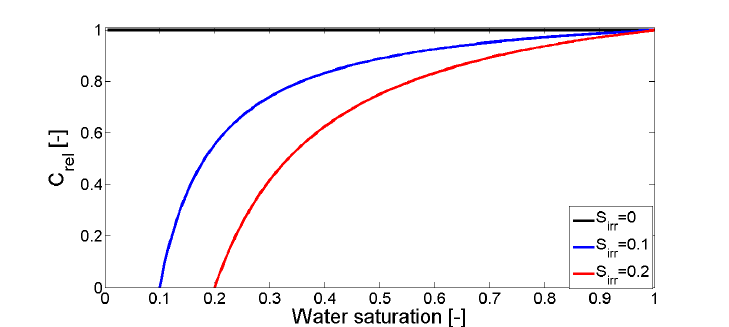
Figure 2. The variation of the relative SPCC with water saturation for the zero surface conductivity ( Σ s = 0) predicted from Equation (30) at three values of S wirr (0, 0.1, and 0.2).